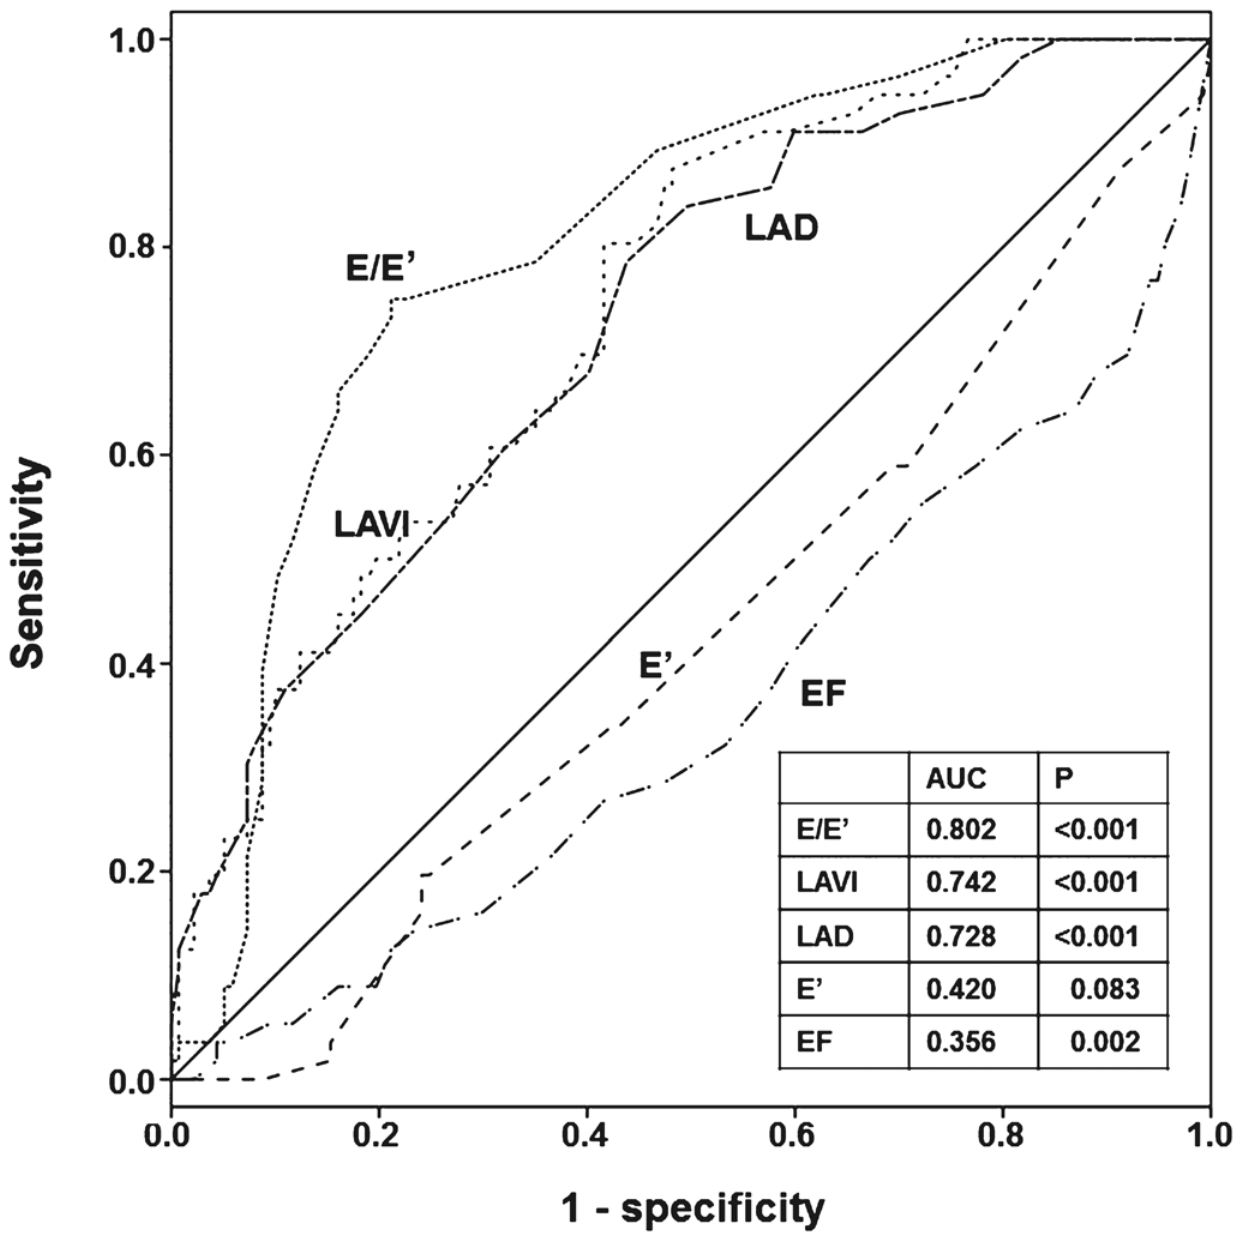
Fig 2. Receiver operating characteristic curve analysis of E/E ’ , LAVI, LAD, E ’ , and EF for CV